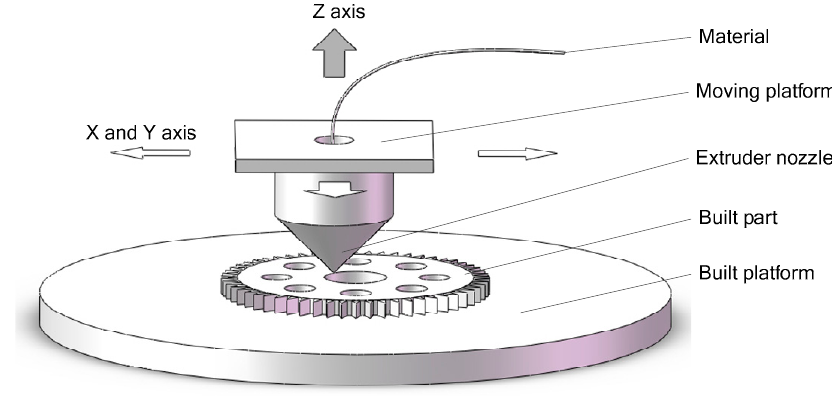
Figure 1. Schematic of the FDM process.